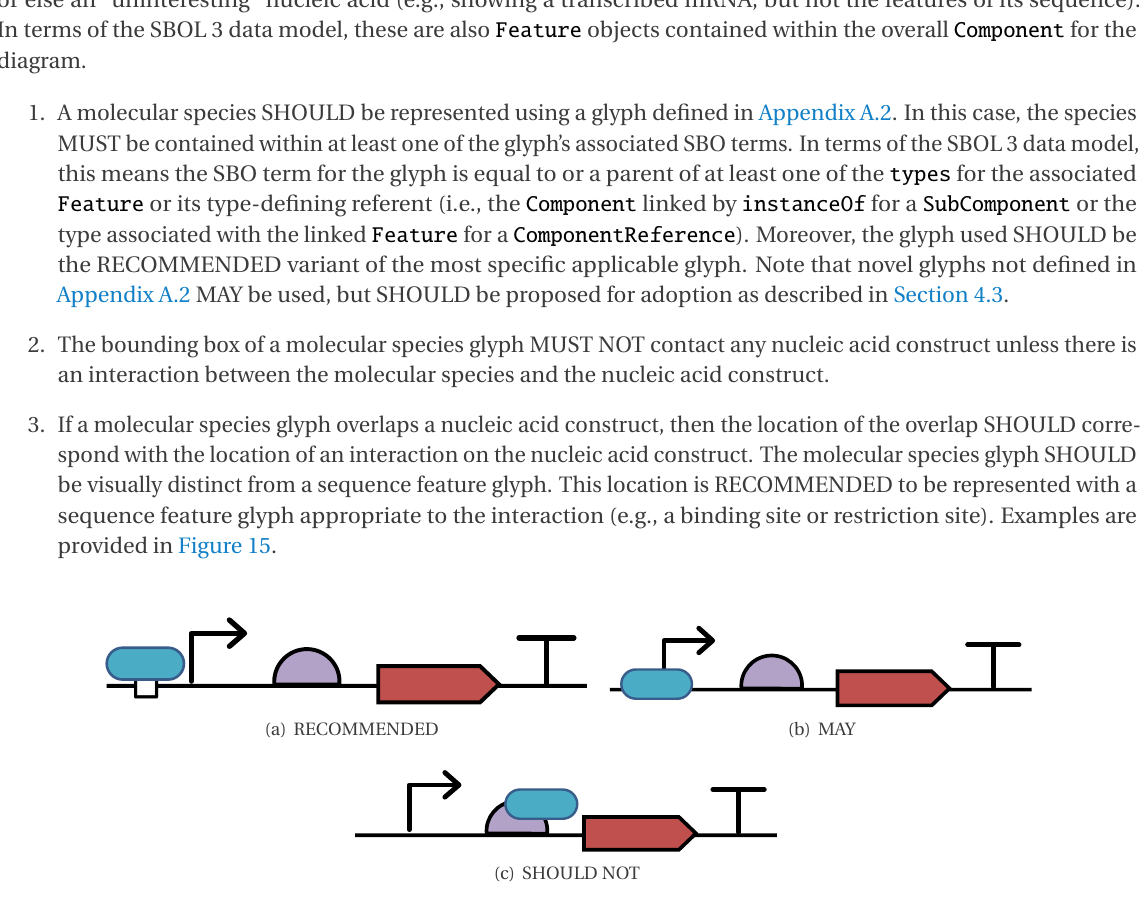
Figure 15: Examples of recommended, allowed, and not recommended representation of an interaction between a molecular species and a nucleic acid construct, in this case regulation of a promoter by a transcription factor protein that binds on the 5’ side of the promoter: (a) shows the RECOMMENDED representation, (b) shows a more generic alternative, and (c) is recommended against because the location does not corresponding with the